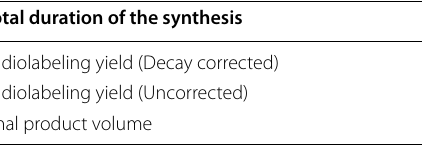
Table 3 General synthesis parameters (n Total duration of the synthesis